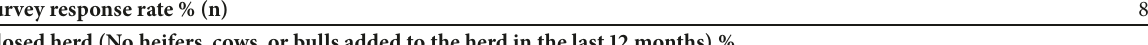
Table 2: Characteristics of enrolled herds from survey results; s.d.: standard deviation; i.q.r.: interquartile range. Survey response rate %